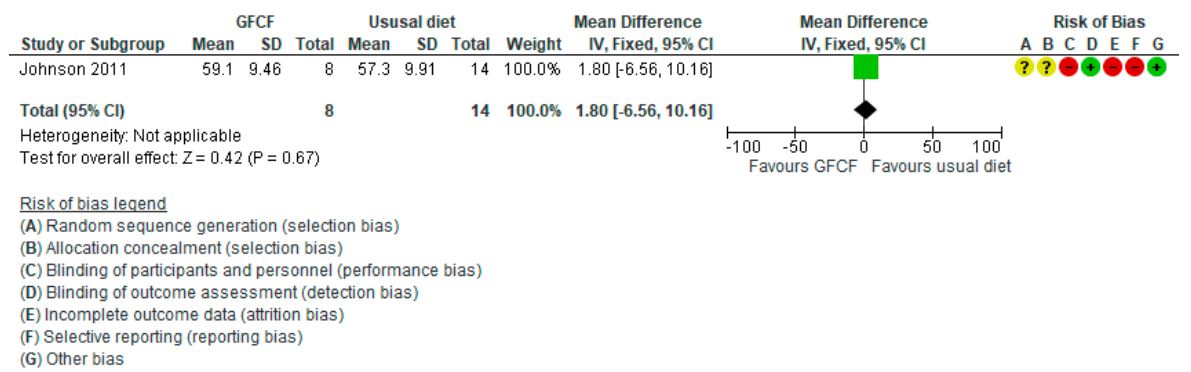
Figure 8. Forest plot of comparison: GFCF vs. usual diet, outcome: parent-reported child’s behavioral difficulties (CBCL Aggression subscale, lower is better).